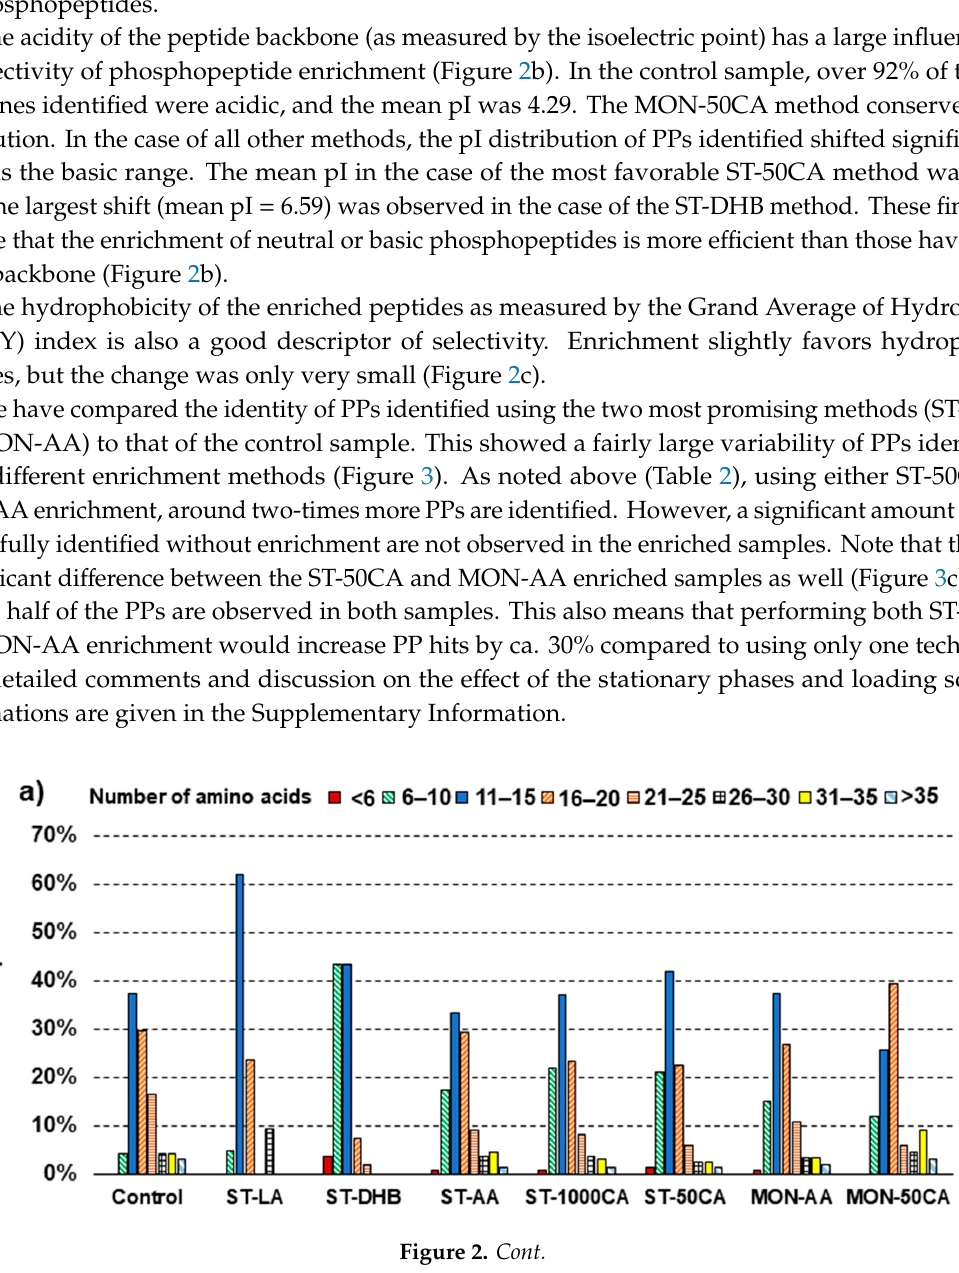
Figure 2. Selectivity regarding backbone characteristics of identified PPs. Relative distributions of unique PPs of ( a ) given peptide length (number of amino acids per peptide), ( b ) pI range, ( c ) GRAVY score range. For each method, the results of 5 parallel enrichments were combined.